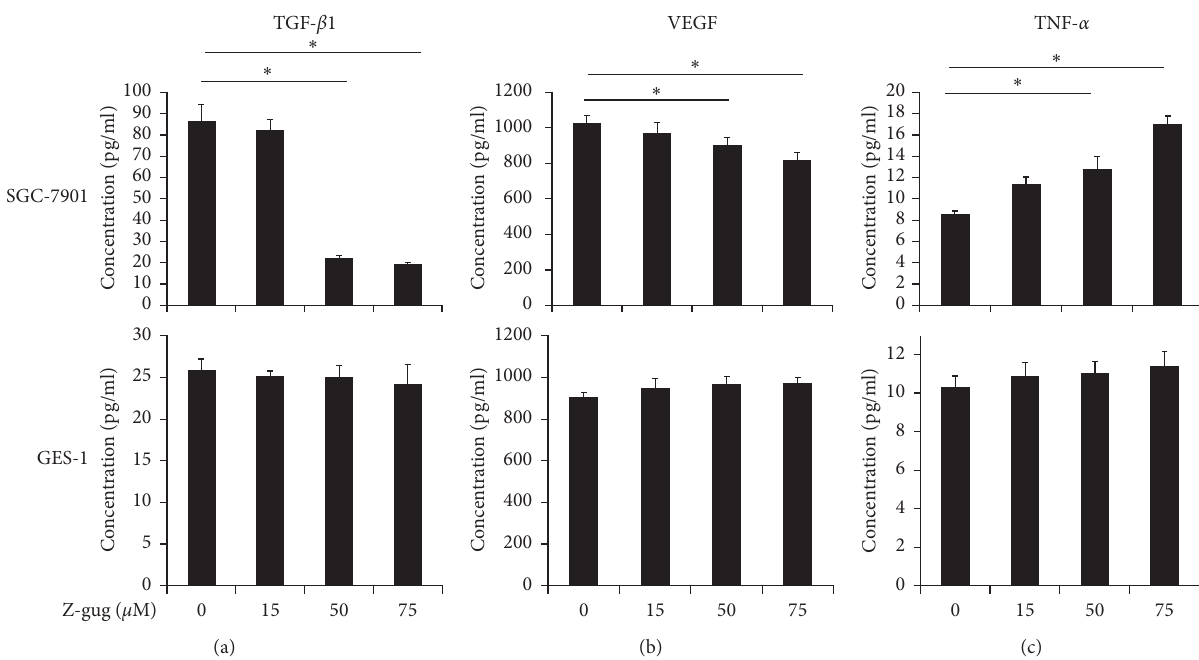
Figure 4: Z-guggulsterone alters TGF- β 1, VEGF, and TNF- α levels in SGC-7901 cells. SGC-7901 (a) and GES-1 (b) cells were treated with 0, 15, 50, or 75 µ M of z-guggulsterone for 24 h. TGF- β 1, VEGF, and TNF- α levels in the culture medium were investigated using ELISA. Data are expressed as means ± SD. ∗ p < 0 . 05 vs. untreated cells. Z-gug,